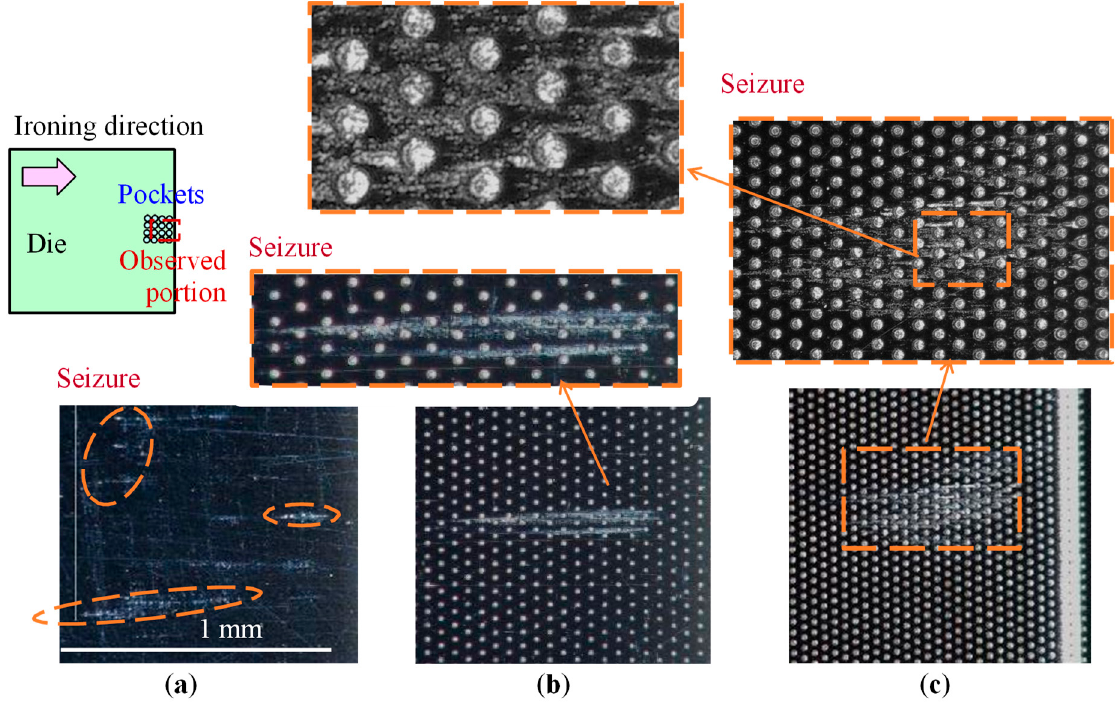
Figure 13. Occurrence of seizure on die with ( a ) smooth surface at r = 15%, and with crossing array pattern, h = 2 µm, L = 50 µm, pocket diameter d of ( b ) 15 µm at r = 15%, and ( c ) d of 30 µm at r = 12%.